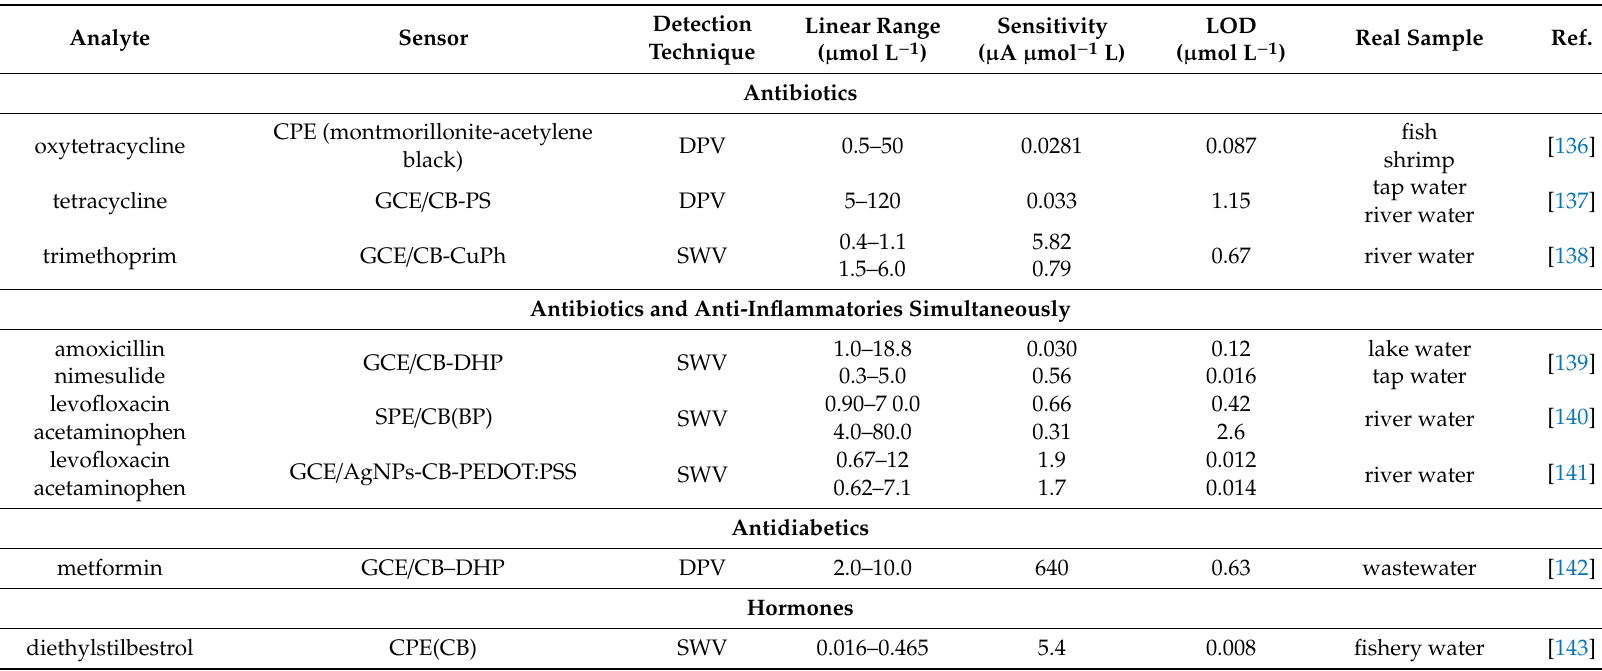
Table 4. Carbon black-based electrochemical (bio)sensors for emerging pharmaceutical pollutants in aquatic species and environmental